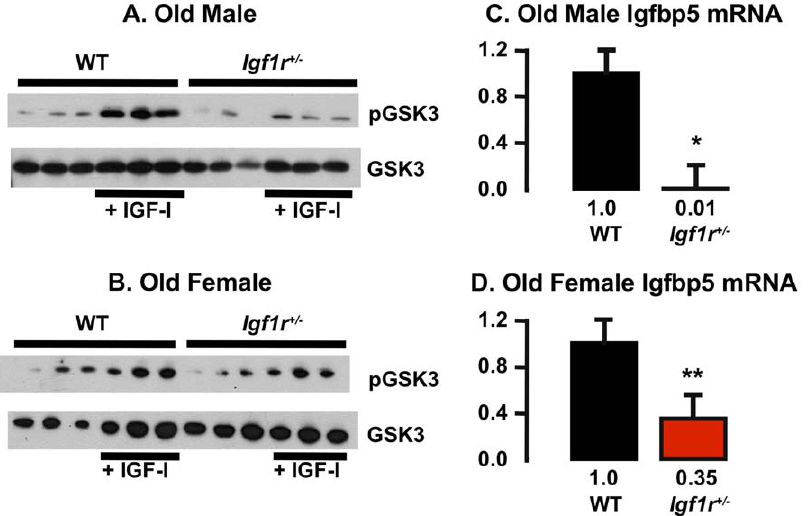
Figure 3. Induction of GSK3 b phosphorylation and levels of Igfbp5 mRNA transcript in WT and Igf1r + / 2 mice. Levels of phosphorylated GSK3 b were measured in the muscle (quadriceps) of 25-month-old male (graph A) and female (graph B) mice following injection of saline or rhIGF-1 (1 mg/kg body wt.) using Western blots as described in Materials and Methods. Three animals were used per group. The expression of Igfbp5 was measured in the same samples using qRT-PCR (graphs C and D). The vertical axis represents expression levels relative to B2M and the error bars represent SEM. P-values of 0.01 and 0.005 are represented by * and **, respectively.